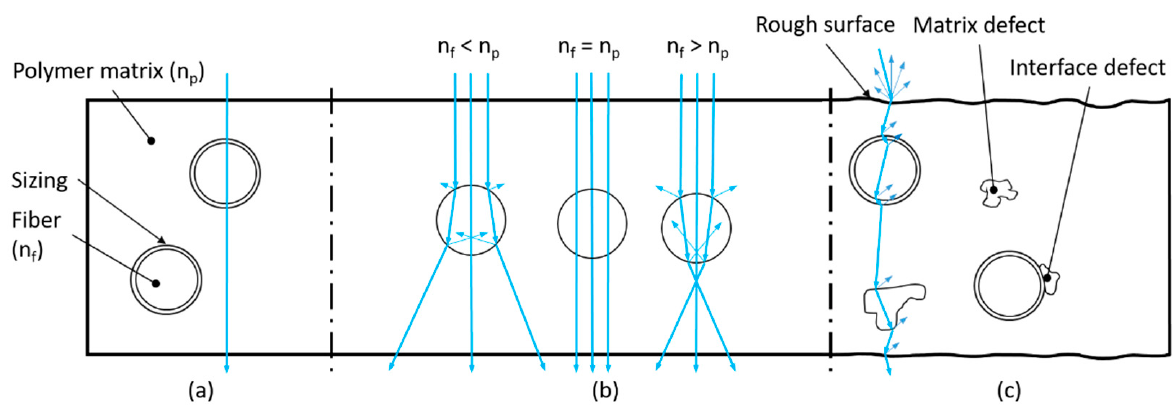
Figure 1. Optical effects of an incident ray permeating a tGFRP with ( a ) ideal properties: matching RI, smooth surface and no defects, ( b ) different levels of RI mismatch between polymer (n p ) and fiber (n f ) [14], and ( c ) realistic properties including defects that decrease the optical quality.